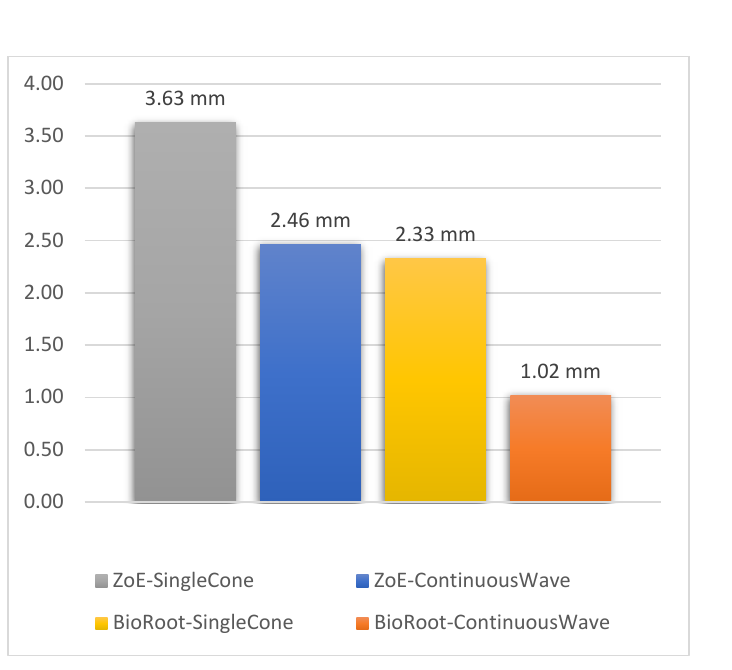
Figure 2. Apical microleakage mean values (mm) and standard deviations (mm) of the studied samples, organized according to the considered factors (endodontic sealer and obturation technique).